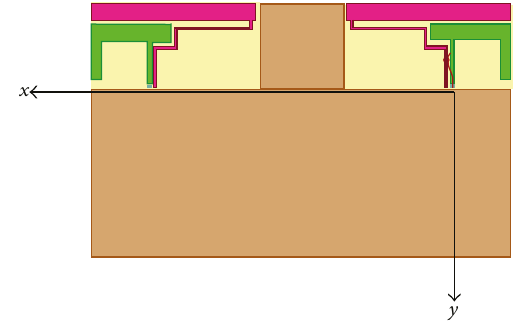
Figure 1: Antenna structure